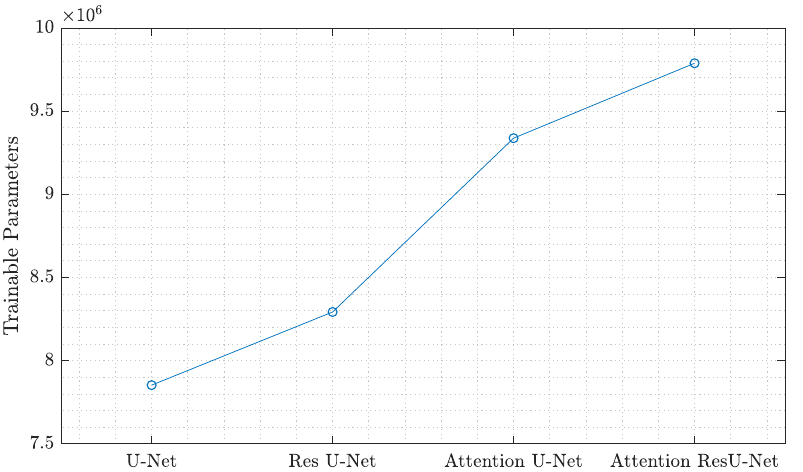
Figure 6. Number of trainable parameters ( × 10 6 ) used for U-Net and its variations. The inclu- sion of attention gates and residual blocks increases the total number of parameters for the plain U-Net architecture.